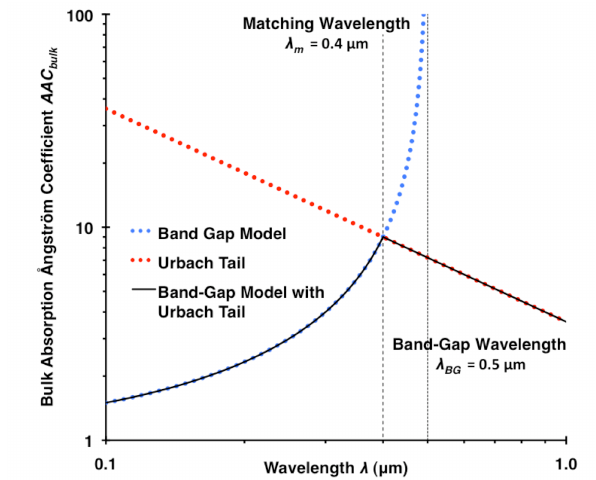
Fig. 4. Bulk absorption coefficient α calculated with the band-gap model (blue dotted line), the Urbach-tail extension (red dotted line), and the band-gap model with Urbach tail (black solid line). Param- eters used for this example are C = 1, λ BG = 0 . 5µm, λ m = 0 . 4µm, λ 0 = 3 . 6µm, and α m = 0 . 1µm − 1 .